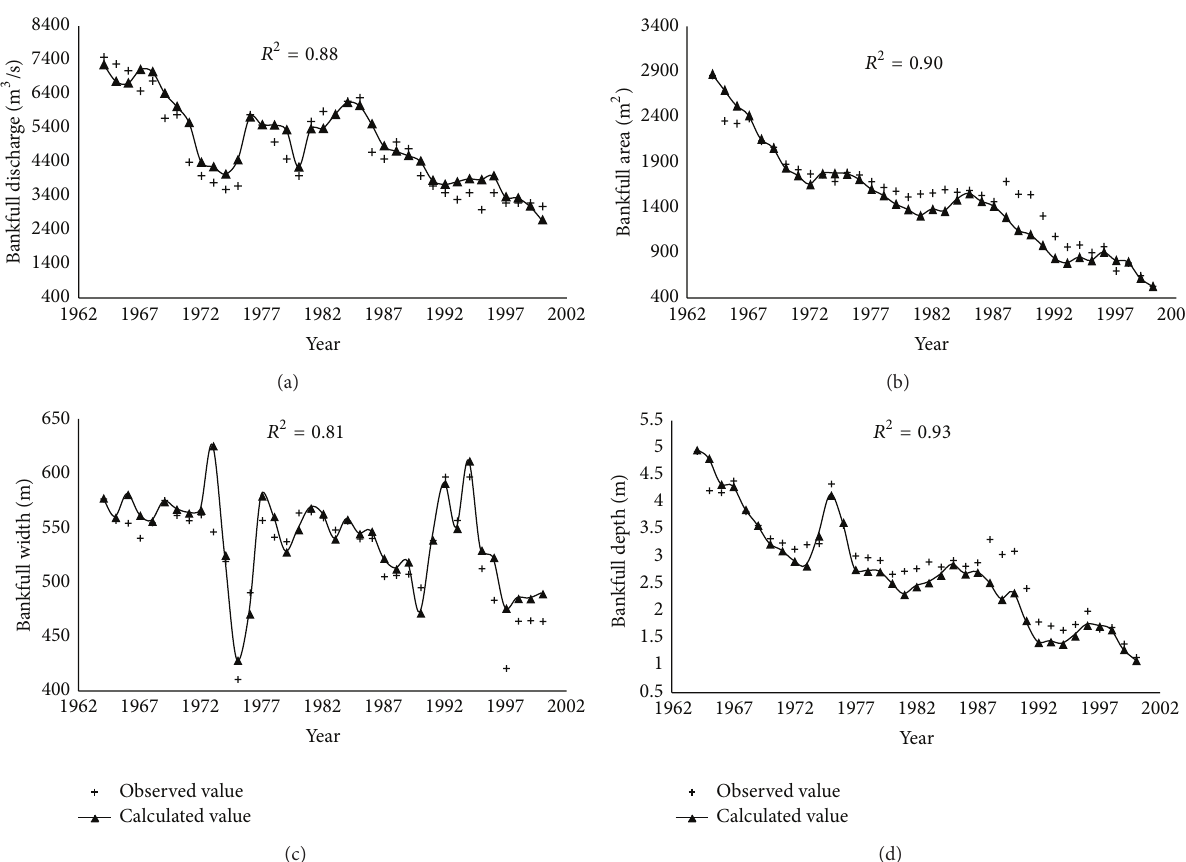
used in the model, together with the daily water discharge data of Heishiguan and Wuzhi Stations. The simulation results are shown in Figure